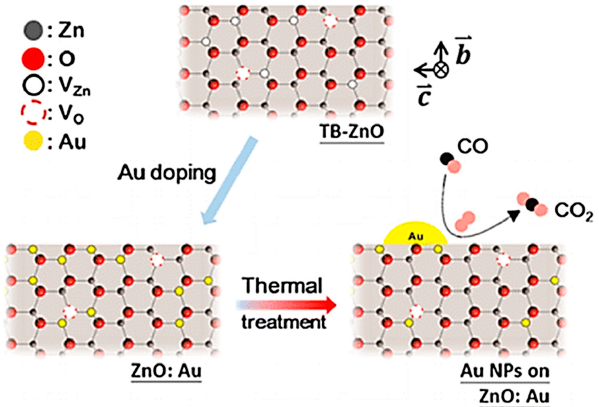
Figure 5. Schematic illustration for Au ‐ doped defect ‐ rich TB ‐ ZnO and their catalytic process. Reproduced with permission from [141]. Copyright American Chemical Society, 2015.